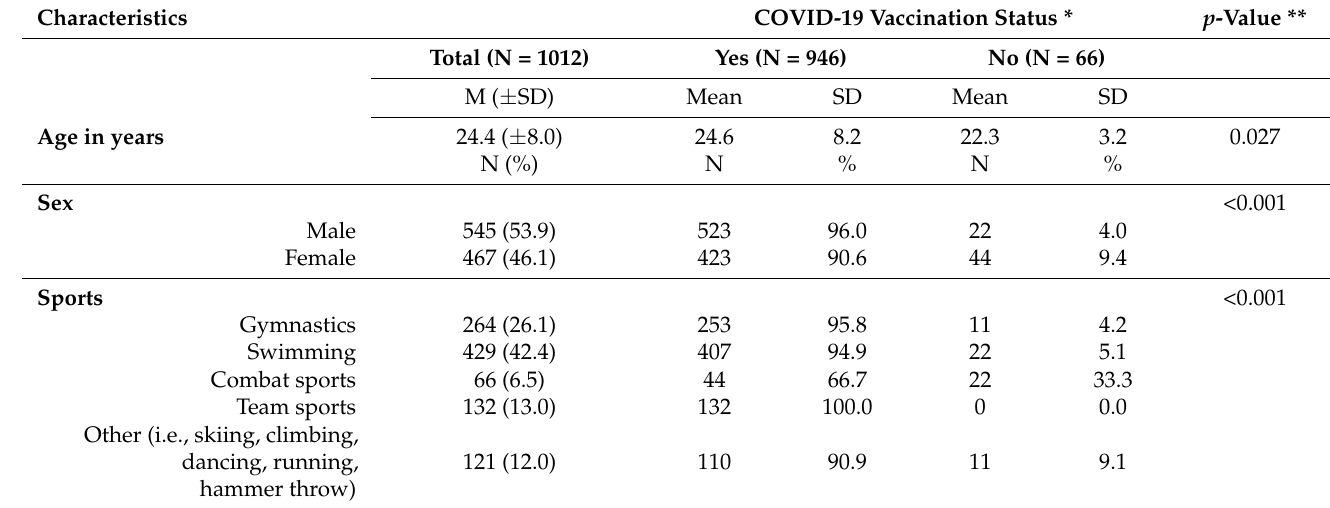
Table 1. Characteristics of 1012 participants by COVID-19 vaccination status *.